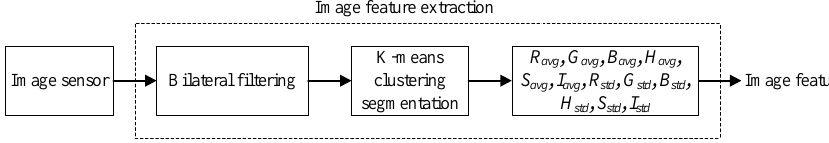
Figure 10. Image features extraction method.